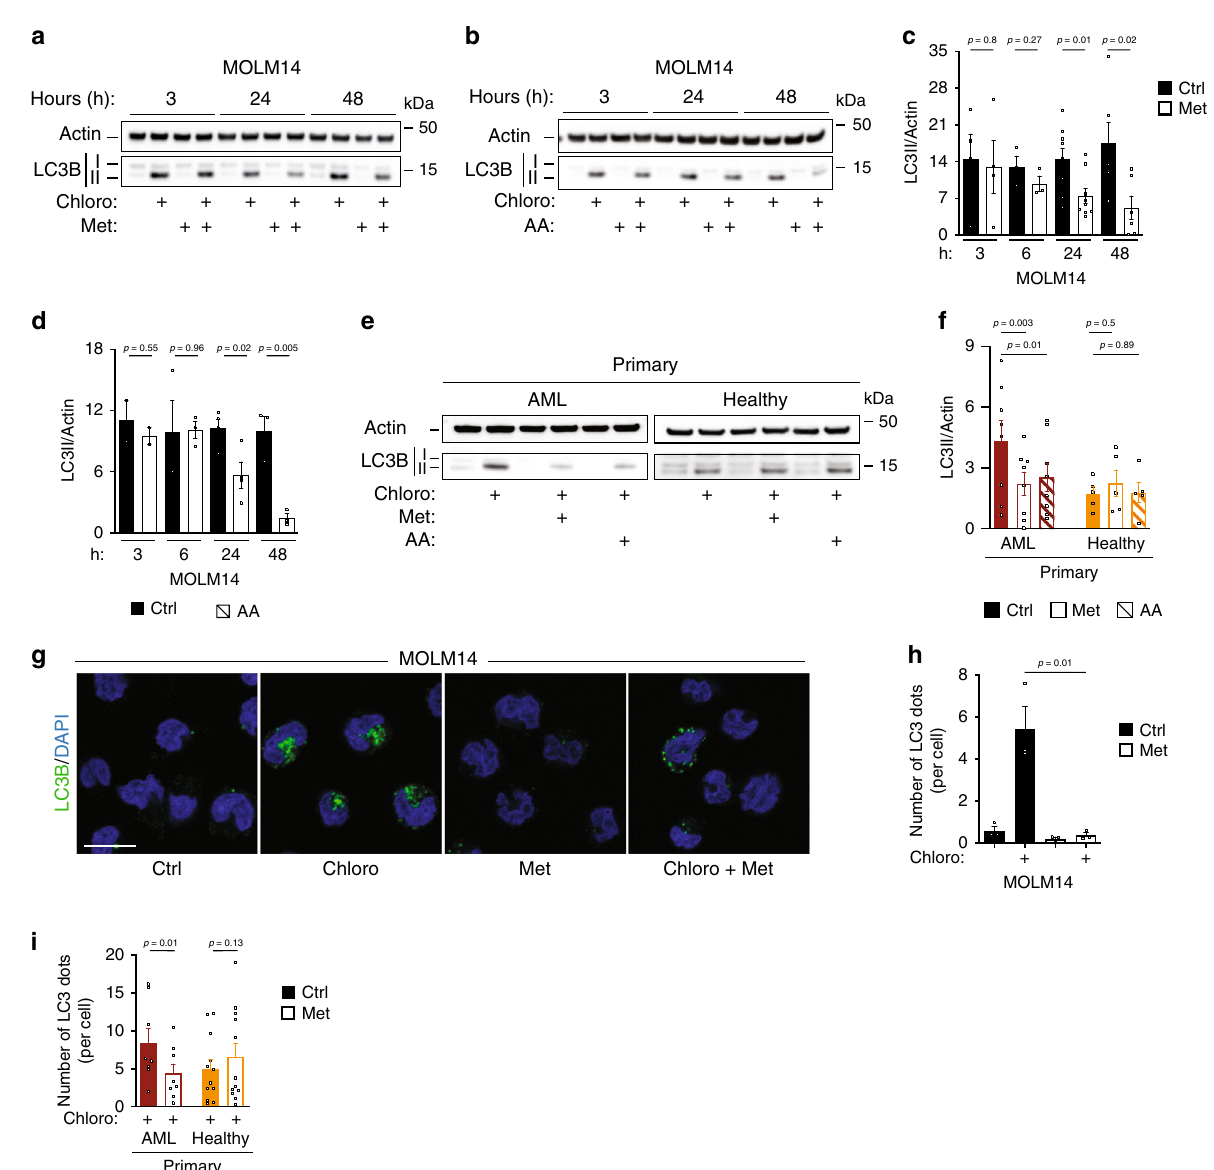
Fig. 3 Inhibition of OxPHOS reduces autophagic fl ux. a , b Western blots of LC3B and actin from at least three independent experiments of MOLM14 cells treated with metformin (Met) ( a ) or with antimycin A (AA) ( b ) ± chloroquine (chloro) for the indicated times are shown. c , d LC3B-II/actin ratios identi fi ed by densitometries from Western blots shown in a , b in MOLM14 cells treated with Met ( c ) or with AA ( d ) in presence of chloro. Data are means ± s.e.m, (at least n = 3, unpaired t -test). e Western blots of LC3B and actin from primary AML ( n = 8) or normal ( n = 5) cells treated with Met or with AA ± chloro. f Primary AML patient cells ( n = 8 with Met, n = 8 with AA) and primary normal hematopoietic cells (PBMC) were treated with Met ( n = 5) or AA ( n = 5) for 48 h in presence of chloro followed by immunoblotting for LC3B and actin. Histograms represent the LC3B/actin ratios obtained by densitometric analysis of Western blots (paired t -test). g , h Representative confocal pictures from three independent experiments of MOLM14 cells treated with Met for 48 h ± chloro, fi xed and stained for LC3B and DAPI. Scale bar: 10 µ m. g Histograms represent the number of LC3B puncta per cell ( h ), ( n = 3, unpaired t -test). i Primary AML patient cells ( n = 8) and primary normal hematopoietic cells (PBMC n = 8, CD34 + n = 4) were treated or not with Met for 48 h ± chloro, fi xed and stained for LC3B and DAPI. Histograms represent the number of LC3B puncta per cell (paired t -test). Data are means ±